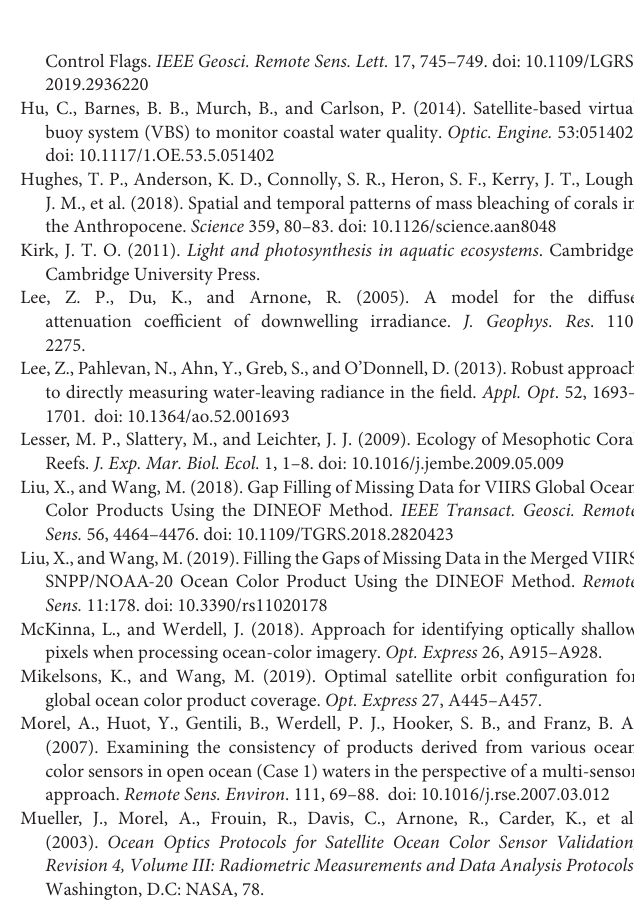
Supplementary Figure 3 | (A) Correlation matrix of in situ and VIIRS measures of log-transformed K d (490) over a 3-days in situ measurement period at 11 West Maui locations ( Figure 2 ) for a range of spatial buffers and time windows applied to the satellite data. The outer horizontal axis indicates the spatial buffer and the outer vertical axis represents the time window, with icons on each representing the space (or time) domain. Together, the time window and spatial buffer make the spatiotemporal cube of satellite data from which values are compiled (gray circles) and the median of those is calculated (black circles). Shading of each plot represents the RRMSE value of individual regression lines between the median satellite observation and the in situ observations. For each scatterplot, the horizontal axis values are the in situ observations from the sites in Figure 2 , all of which were taken during November 26–28, 2018, and the vertical axis values are all satellite observations associated with that in situ measurement within the time window and space buffer indicated. The number in the upper left corner is the RRMSE value for that plot; the number in the bottom right corner is the total number of satellite observations (gray circles) displayed in the plot. (B) Enlarged scatterplot for recommended spatiotemporal aggregation (5-pixels, 7-days). Axis tick values in (B) are the same as all scatterplots in (A) and major tick marks are bold for all scatterplots. Supplementary Figure 4 | (A) Correlation matrix of in situ and VIIRS measures of log-transformed K d (490) over a 4-years in situ measurement period at one southwest Puerto Rico location ( Figure 5 ) for a range of spatial buffers and time windows applied to the satellite data. The outer horizontal axis indicates the spatial buffer and the outer vertical axis represents the time window, with icons on each representing the space (or time) domain. Together, the time window and spatial buffer make the spatiotemporal cube of satellite data from which satellite